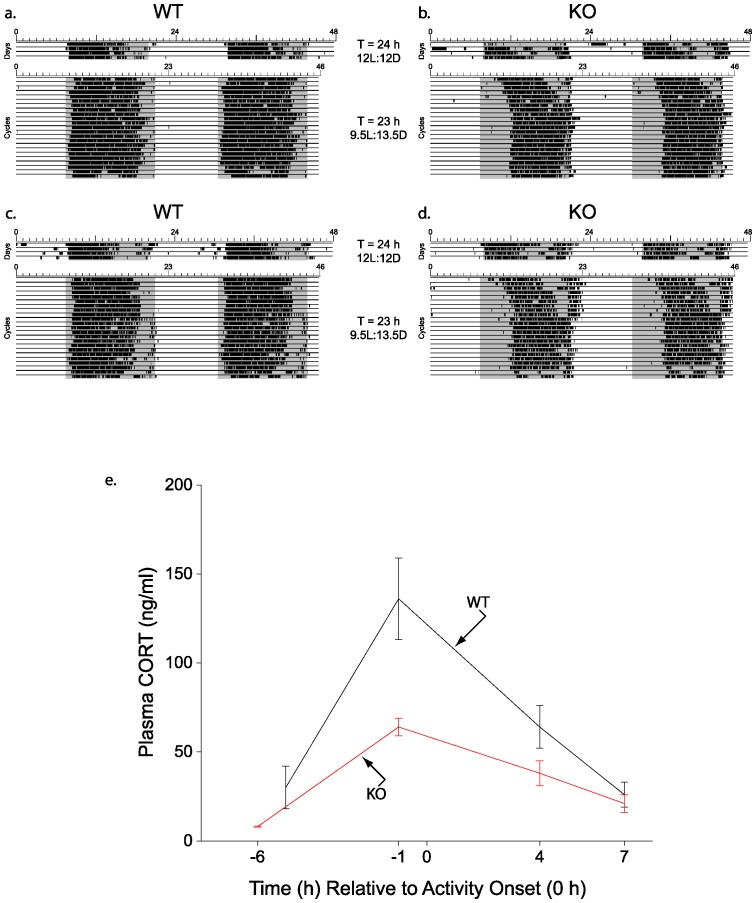
Activity and corticosterone levels of wild type and 5-HT1B knockout mice in 9.5L:13.5D conditions.Wheel-running activity records double-plotted in the standard manner, with each day's activity plotted beneath and after the previous day's activity (shaded region represents dark). Examples of activity of wild type (WT; a & c) and 5-HT1B knockout (KO; b & d) mice transferred from 12L:12D (T = 24 h) to 9.5L:13.5D (T = 23 h) conditions. Animals re-entrained to the short-day 23 h cycle although wheel-running activity onsets, relative to light offset, were significantly more delayed in KO animals compared to WT animals in the 9.5L:13.5 D conditions (p<0.001). (e) Plasma corticosterone (CORT) levels exhibited a diurnal rhythm with peak values observed one hour before activity onset (−1 h time point); the peak plasma CORT value for KO animals was significantly less than peak plasma CORT value of WT mice (p<0.01). 9–13 plasma samples/time point.